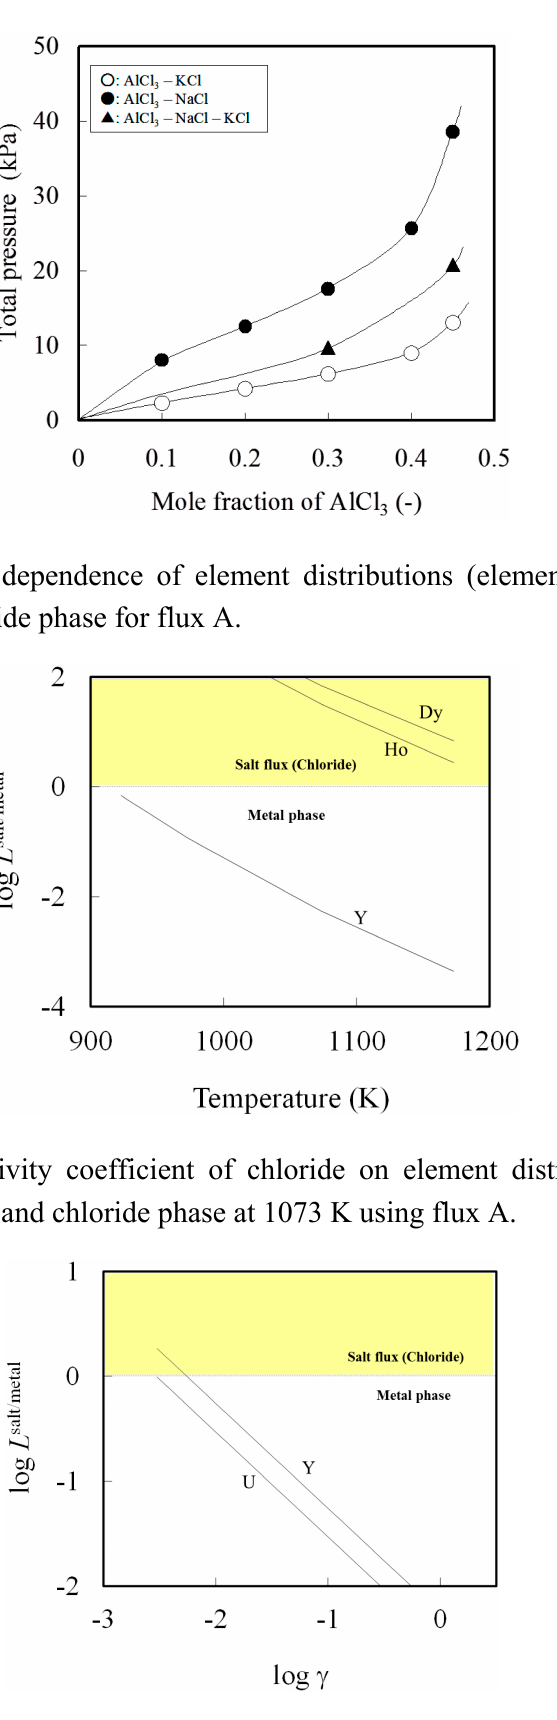
–NaCl, AlCl –KCl and 3 3